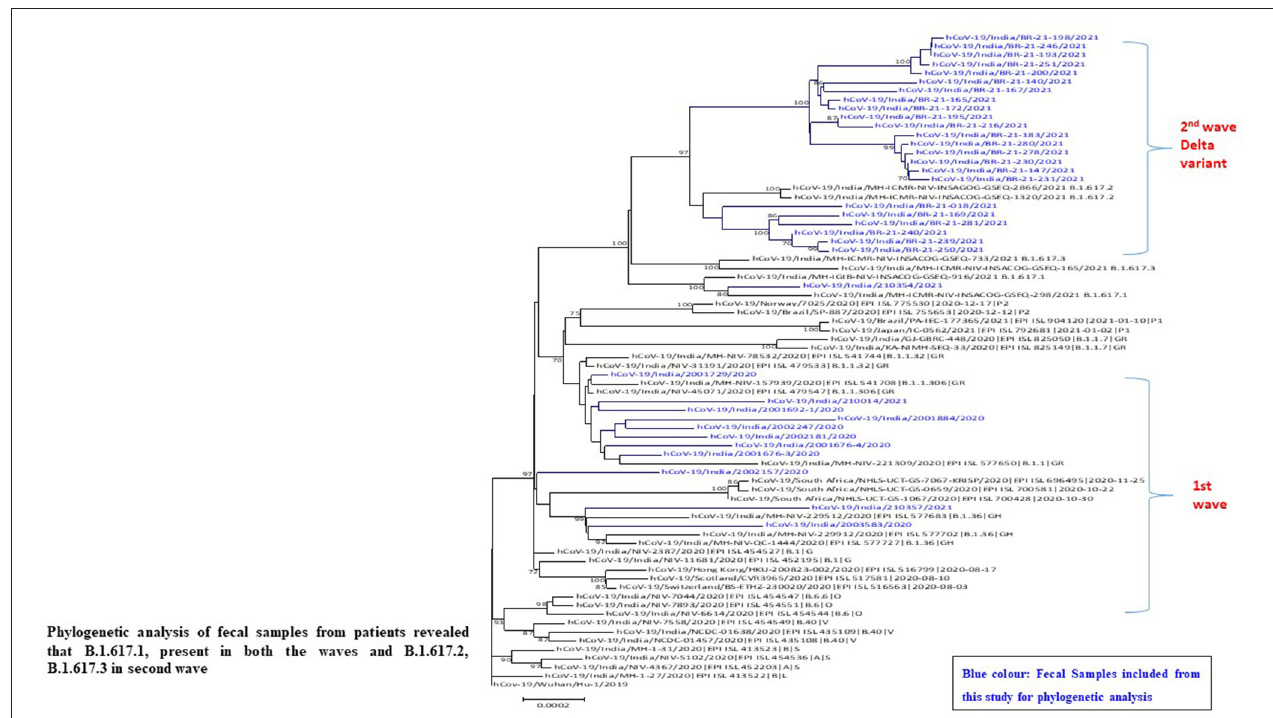
FIGURE 5 | Phylogeny of SARS-CoV-2 genomes from fecal samples of SARS-CoV-2 positive patients from Pune, Maharashtra according to